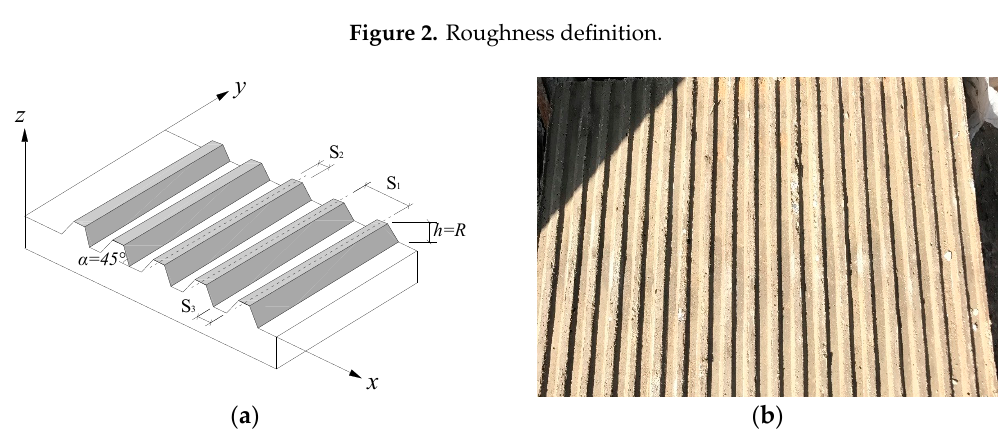
Figure 3. Schematic diagram and photograph of the concrete plate: ( a ) schematic diagram; ( b ) photograph of the concrete plate .